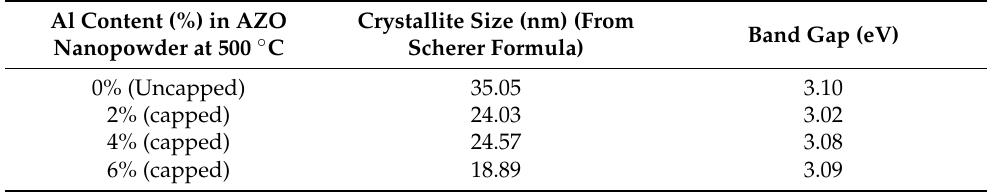
Table 2. Variation in crystallite size and energy band gap of AZO with different Al concentrations. Al Content (%) in